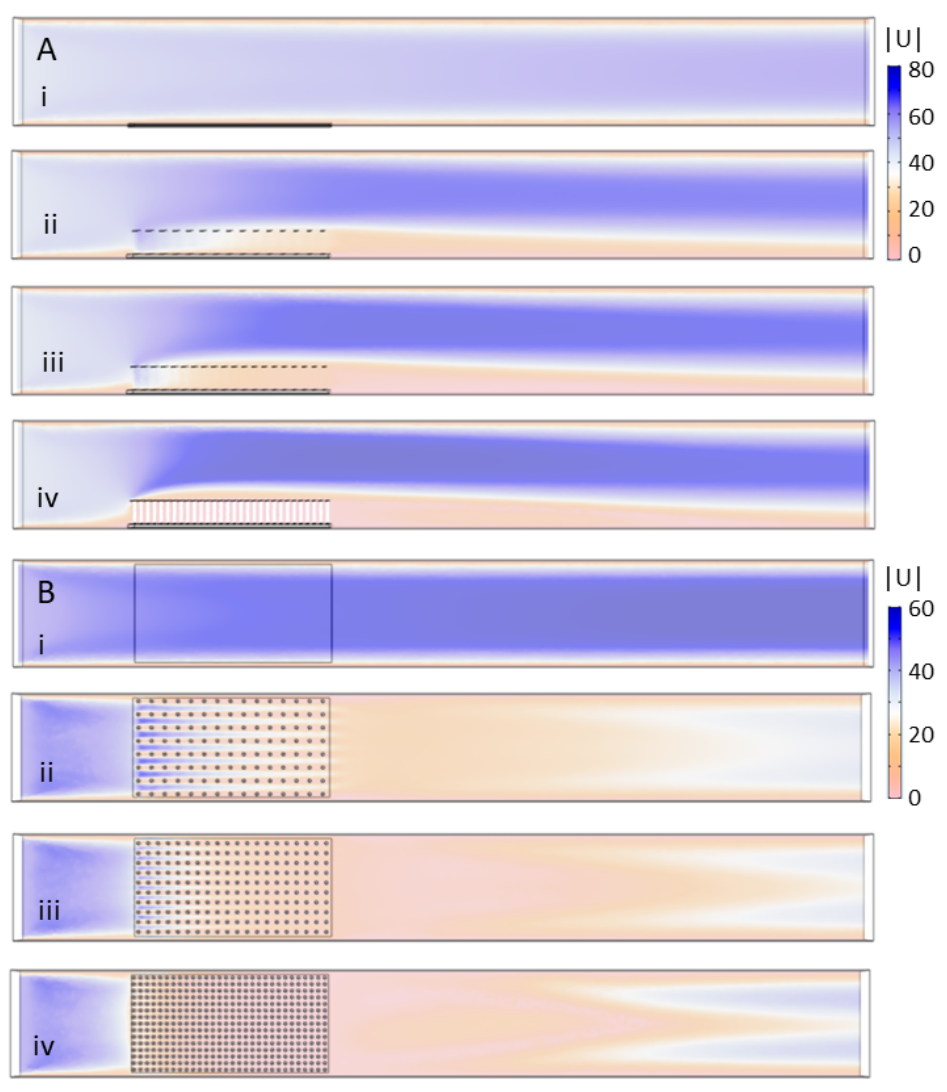
Figure 6. Velocity magnitude of the flow through models of varying cylinder density: ( A ) the velocity magnitude in mm/s taken in a vertical plane tangential to the direction of flow and through the center of the tank; and ( B ) the velocity magnitude in a horizontal plane 1 cm above the bottom of the tank. The models considered include: (i) no model; (ii) 8 × 15 cylinders; (iii) 10 × 20 cylinders; and (iv) 15 × 30